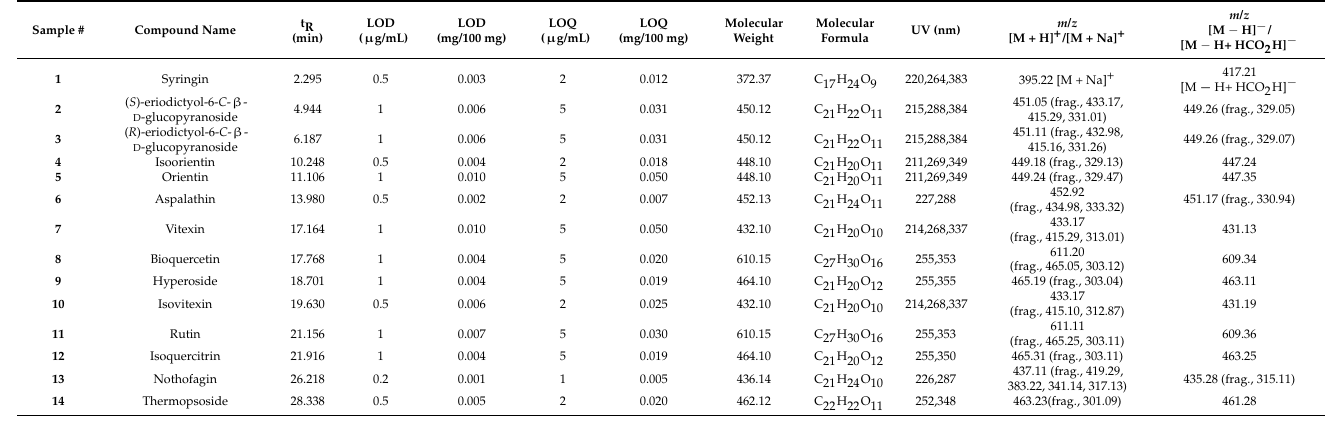
Table 2. Compound name, retention time (min), LOD, LOQ, UV spectra, M.wt, molecular formula, and MS of compounds used for analysis of A. linearis .